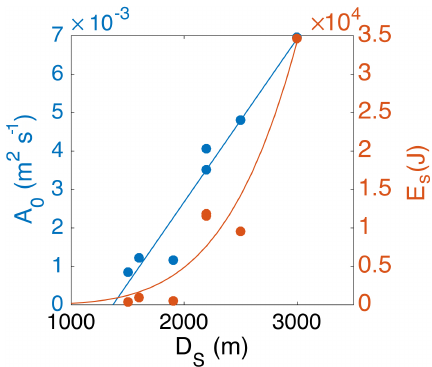
Figure 13. Maximum source amplitudes, A 0 (left in blue) and ra- diated energies, E s (right in orange) versus spatial extensions of the seismic locations, D s . The lines show the least-squares linear fit- ting of the source amplitude vs. distance (blue; R 2 = 0 . 95) and the power-law fit of seismic energy vs. distance (orange; R 2 = 0 .